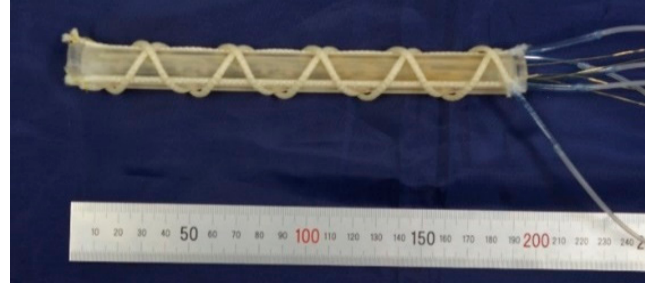
Figure 7. The fabricated soft robot arm.